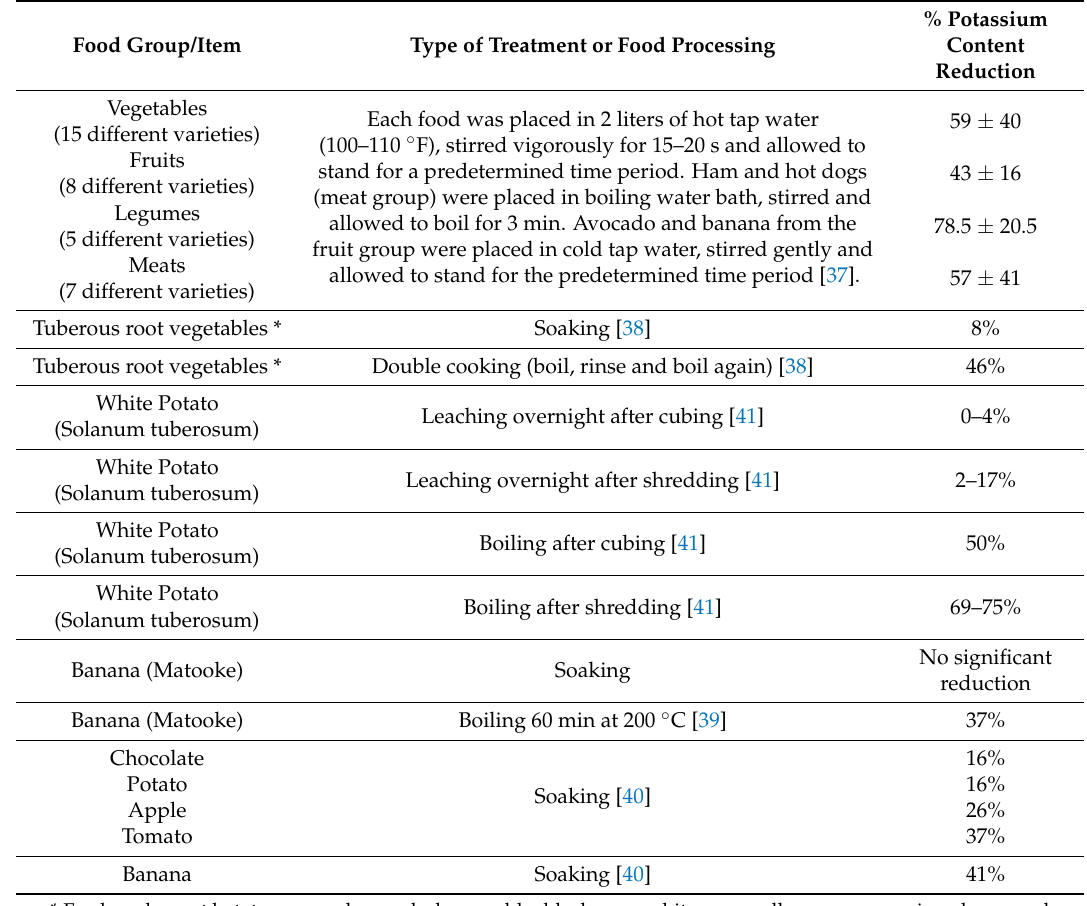
Table 4. Potassium removal by home-based cooking